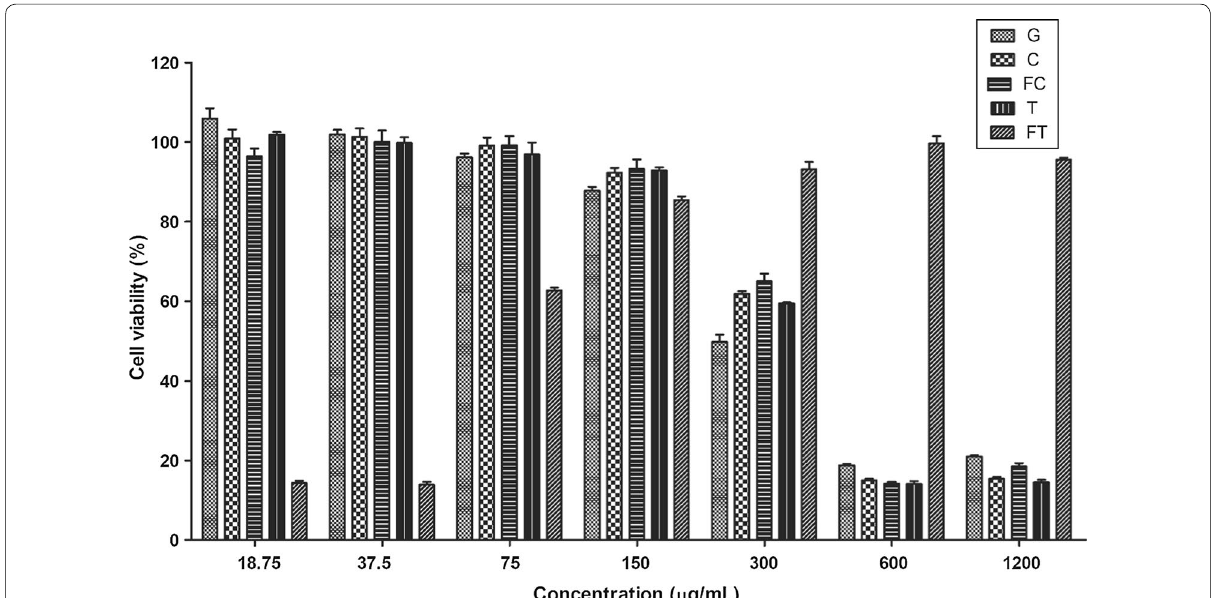
Fig. 2 Cell cytotoxicity of ethanol extracted oyster mushroom against Raw 264.7 cells. Ethanol extracted oyster mushroom grown up on G basal medium, CB common buckwheat medium, FCB fermented common buckwheat medium, TB tartary buckwheat medium, FTB fermented tartary buckwheat medium against Raw 264.7